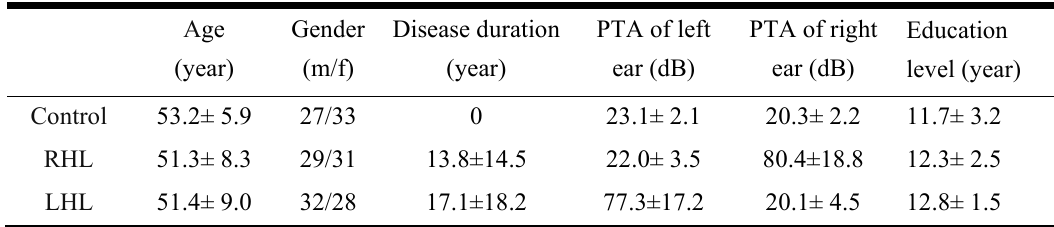
Table 1. The data analysis of all